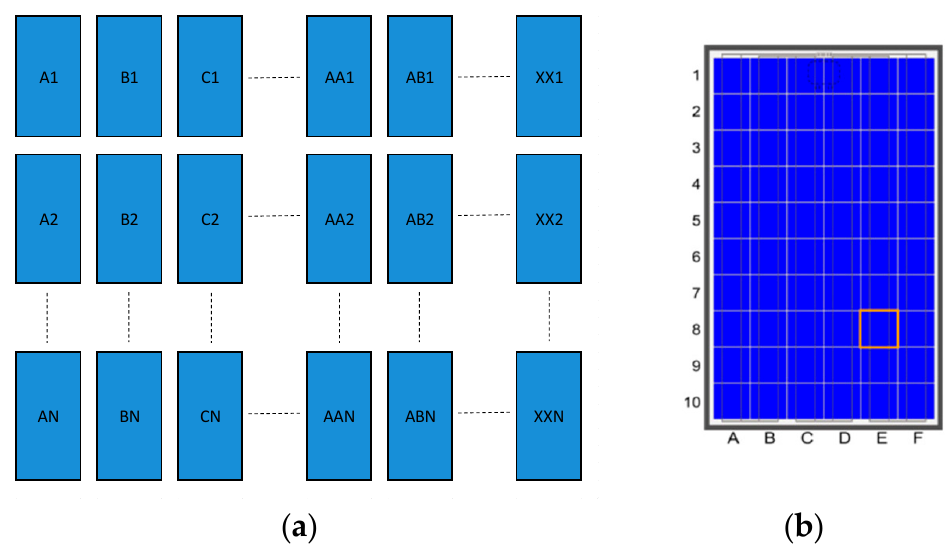
Figure 4. Coding system for identification of PV modules and cells. ( a ) Identification matrix of plant PV modules, and ( b ) the cells in each PV module from a front view.